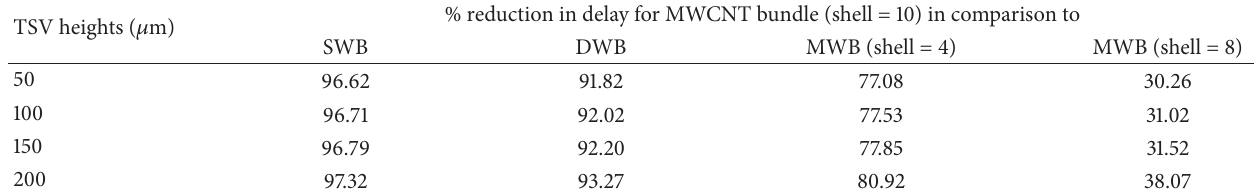
Table 2: Percentage reduction of in-phasedelay for 10-shellMWCNT bundled TSVw.r.t. SWCNT, DWCNT, and 4-shell and 8-shell MWCNT bundle based TSVs.